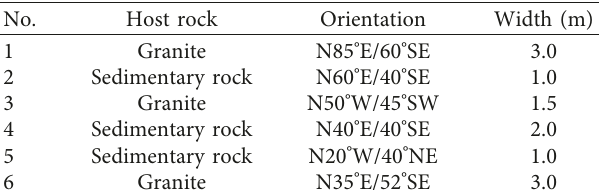
Figure 2: The 3D slope model for the time-history analysis, which consists of soil, and highly weathered (H.W.) and moderately weathered (M.W.) rock. The bottom (greenish block) consists of slightly weathered (S.W.) rock. Six fault gouges within the slope are considered in the model. Fault gouges 1, 3, and 6 have a granitic origin, and fault gouges 2, 4, and 5 have a sedimentary origin. Table 1: Orientation, width, and host rock type of the six fault gouges within the modelled slope. The slope is oriented N02 ° E/ 51 °